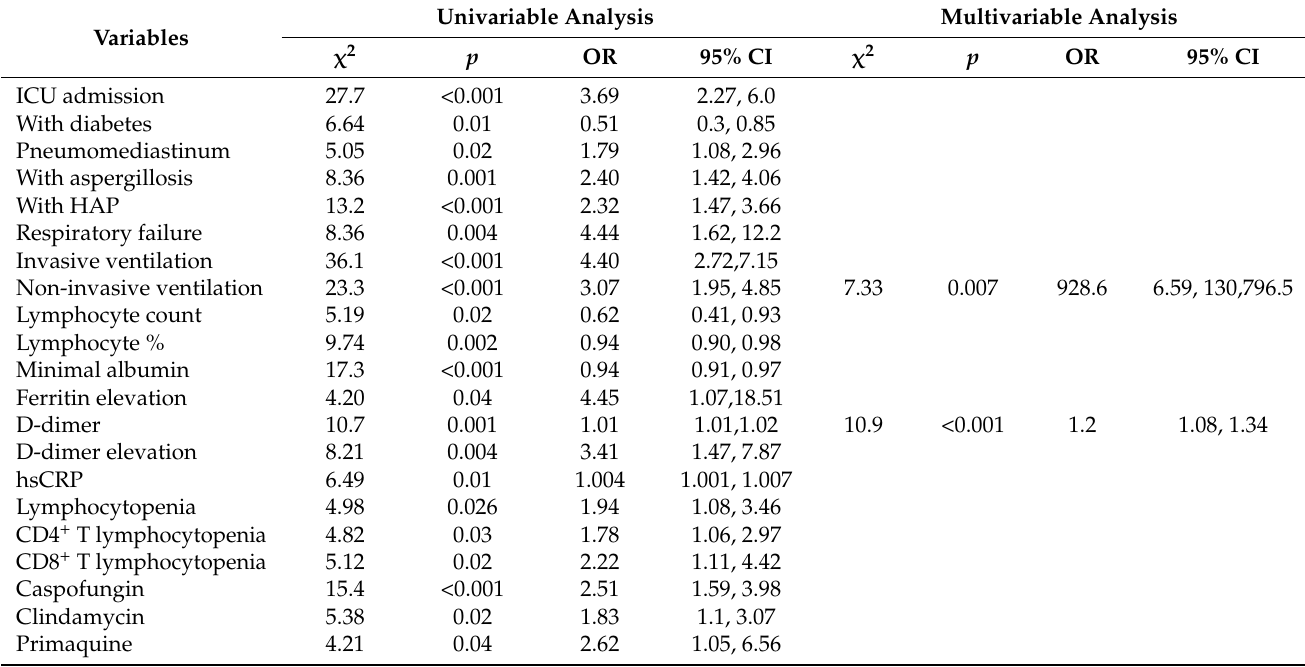
Table 4. The prognostic analysis from the univariable and multivariable analysis for